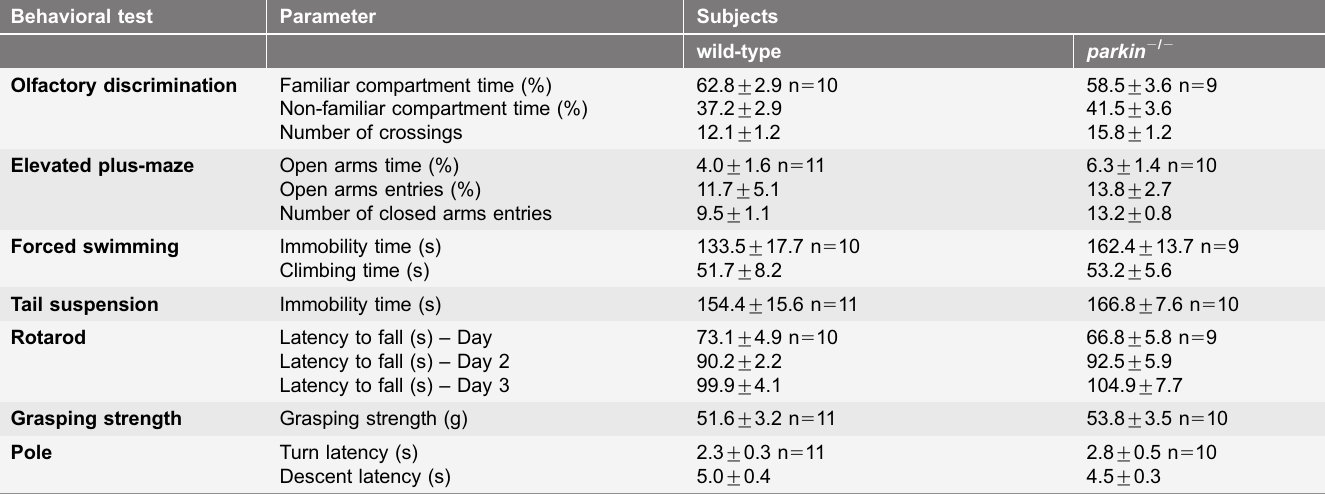
Table 1. Summary of the performance of wild-type and parkin knockout ( parkin 2 / 2 ) mice on behavioral tests evaluating olfactory, emotional and motor